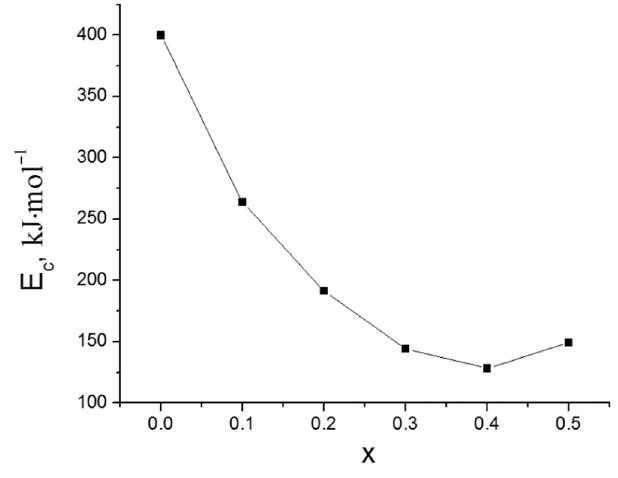
Figure 6. Crystallization activation energy of Li 1.5+ х Al 0.5 Ge 1.5 Si x P 3 − x O 12 glasses as a function of x .